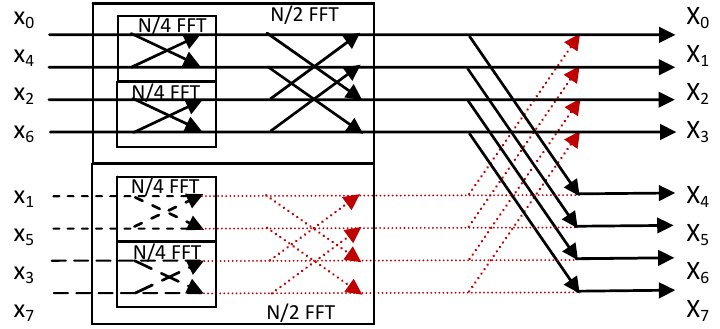
Figure 4. Implementation of an 8-point DFT as a radix-2 DIT FFT (the red arrows indicate zero butterfly